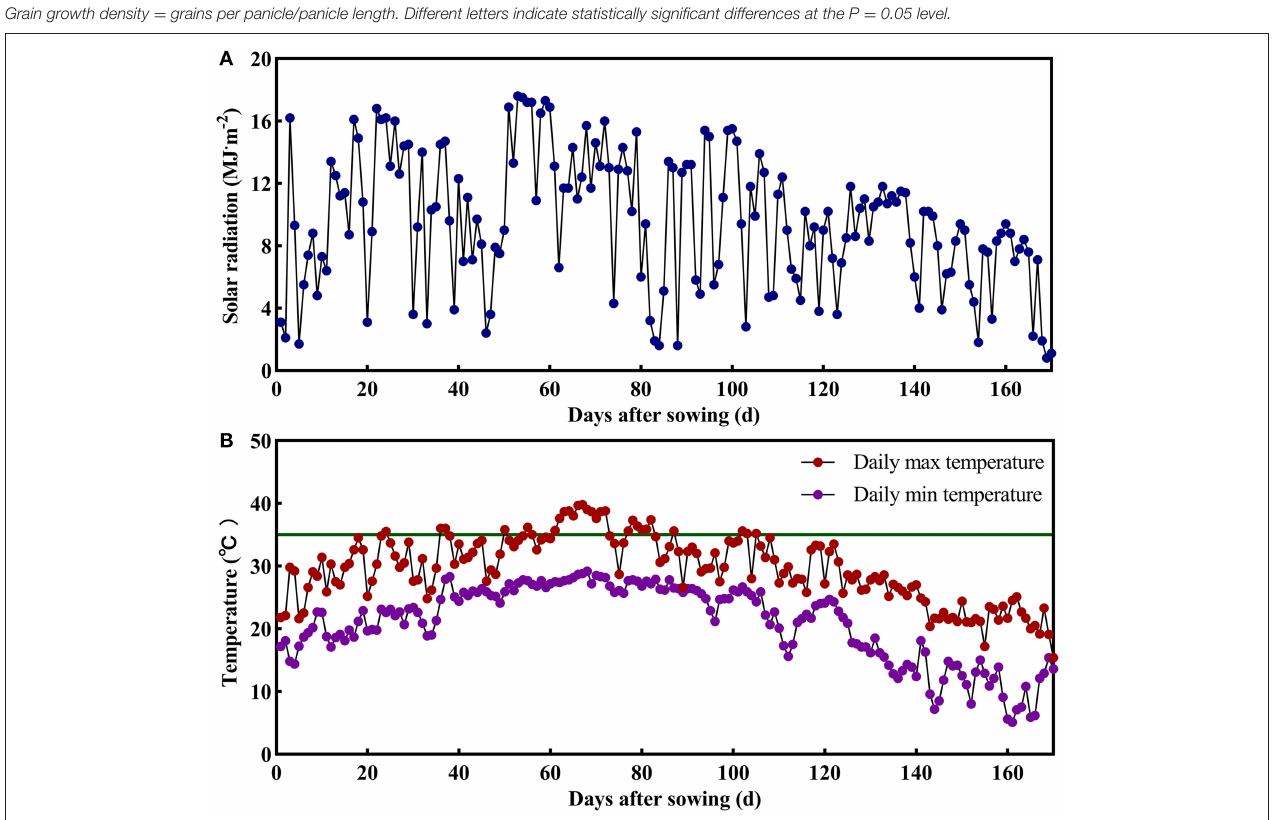
FIGURE 1 | Daily photosynthetically active radiation and daily temperature during the growth period of CJ03 and W1844 at the experiment site of Danyang, Southeast China. The green line indicates a high temperature of 35 ◦ C. (A) , the daily photosynthetically active radiation. (B) , the daily temperature. repeated three times by putting the residue in HClO 4 .